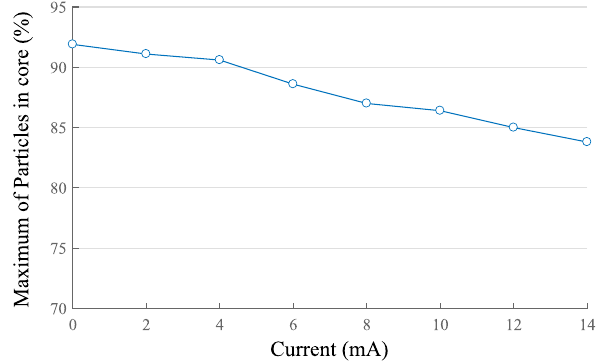
FIG. 5. Plot of optimal field gradient settings for quadrupole doublet magnets at different values of deuteron beam